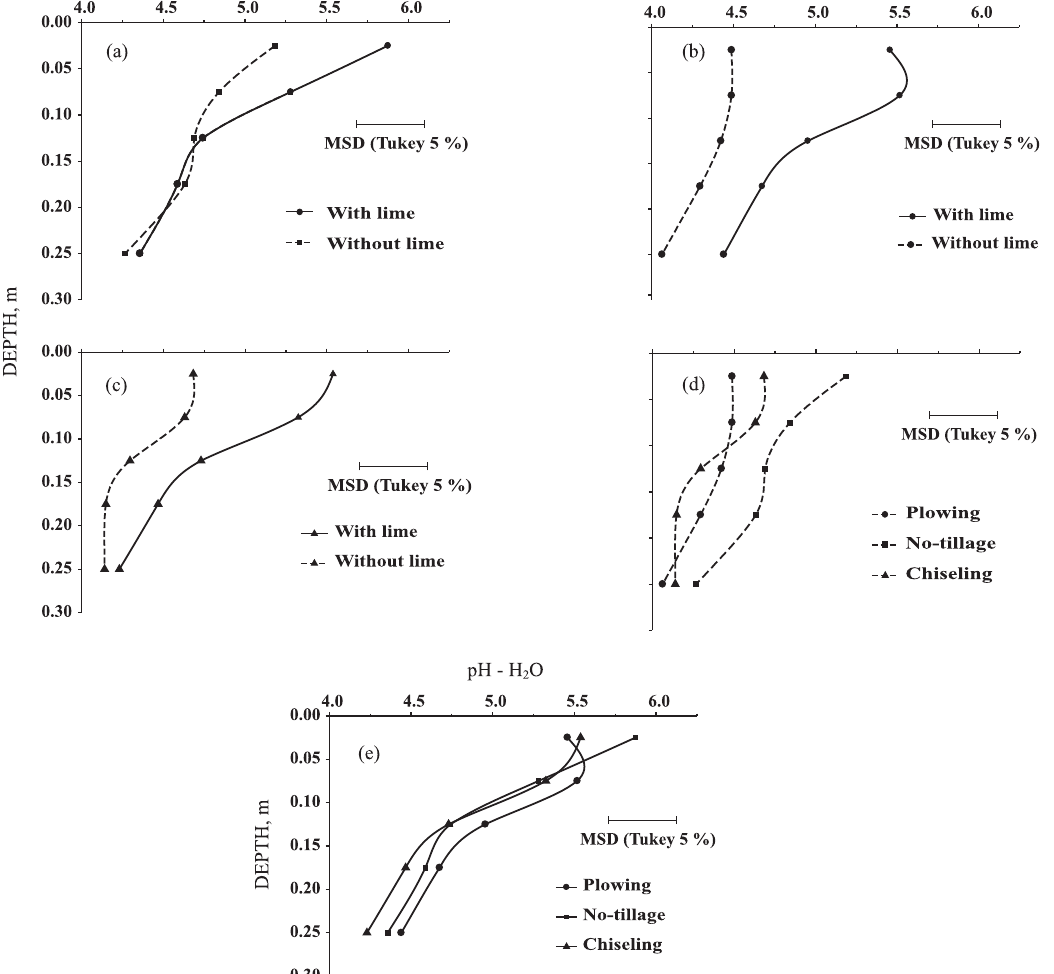
Figure 1. Water pH values in an Oxisol under the no-till system, submitted to the modes of tillage: no tillage (a), plowing (b), chiseling (c) and liming: without lime (d) and with lime (e). MSD (minimum significant